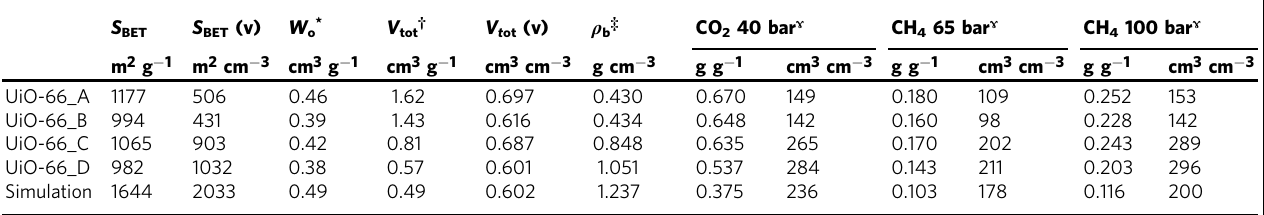
Table 1 Textural and adsorption properties of monolithic UiO-66 S